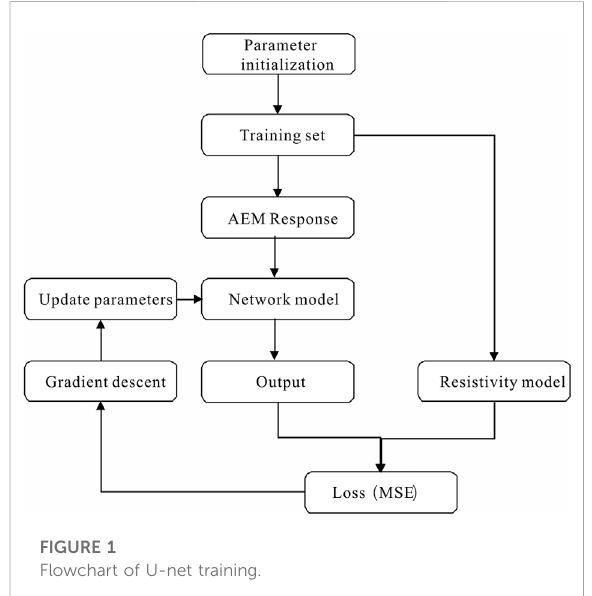
put the normalized training set into the training process shown in Figure 1. After that, we use an Adam optimizer (Diederik and Jimmy, 2014) to update the weights of the network and minimize the loss function to obtain the best training performance. In the network training process, we set the initial value of learning rate to 10 − 4 and the number of samples per batch to 32. The loss function used here is de fi ned as the mean square error (MSE) of the difference between the model parameters and the predicted ones,